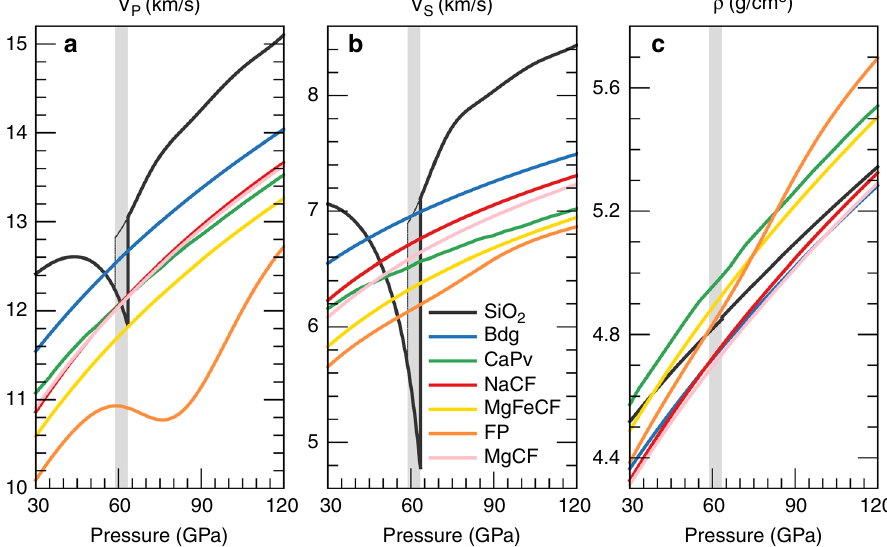
Fig. 3 Comparisons of velocities and density between CF-type phases and other lower-mantle minerals along the normal mantle geotherm. a compressional wave velocities (V P ), b shear wave velocity (V S ), and c density ( ρ ). The normal mantle geotherm is derived from Brown and Shankland (1981) 47 . Data sources: NaCF, NaAlSiO 4 CF-type phase, this study; MgCF, MgAl 2 O 4 CF-type phase, this study; MgFeCF, Mg 0.75 Fe 0.25 Al 2 O 4 CF-type phase, this study; SiO 2 , stishovite and the CaCl 2 -type silica, Yang and Wu (2014) 37 ; Bdg, Mg 0.92 Fe 0.08 SiO 3 bridgmanite, Shukla et al. (2015) 34 ; CaPv, Ca- perovskite, Kawai and Tsuchiya (2015) 36 ; FP, Mg 0.82 Fe 0.18 O ferropericlase, Wu et al. (2013) 64 . Grey areas represent the calculated phase boundary between stishovite and the CaCl 2 -type silica 37